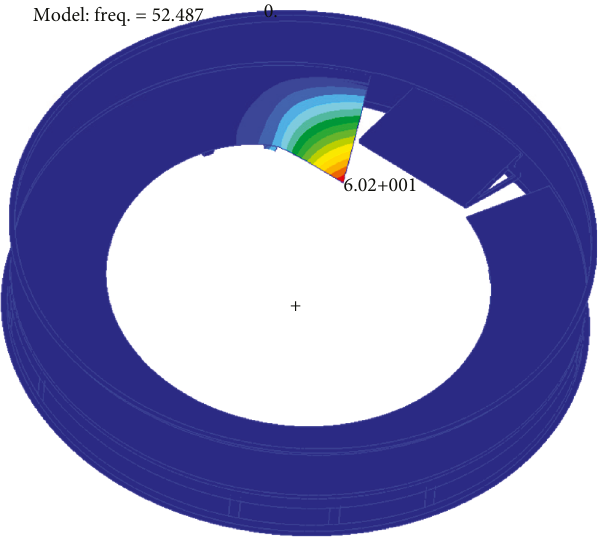
Figure 9: First modal shape of the equipment